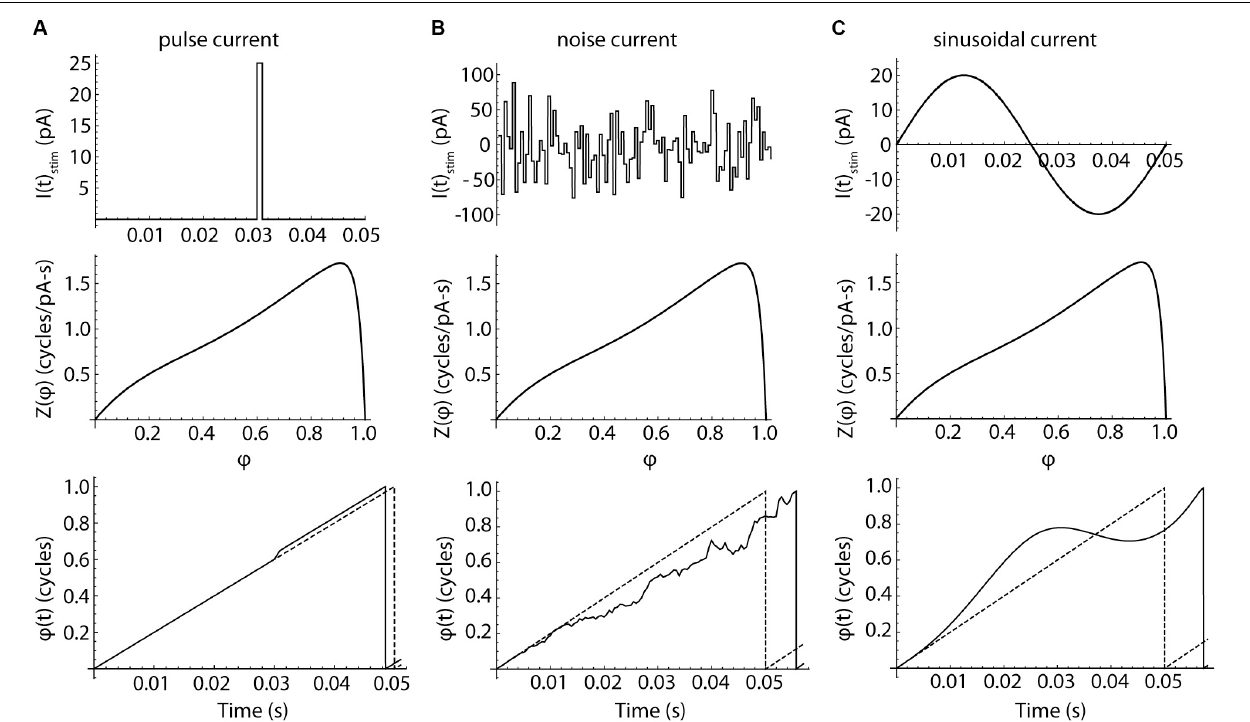
FIGURE 7 | The responses of phase neurons. (A) Response to a brief current pulse. Charge delivered by a current pulse (top) causes a phase shift in a noise-free neuron, whose phase otherwise advances at a constant rate F cell . The cell fires when its phase reaches a value of 1. The depolarizing pulse produces a change in spike time. The size of the phase shift and the change in the spike time are determined by the value of the phase resetting curve at the time of the stimulus. The evolution of phase over time in the absence of any perturbation is indicated by the dotted line. (B) Pulsed noise, like that used to measure spiking resonance, produces a sequence of phase shifts. Each pulse arrives at a phase determined by the entire sequence of preceding pulses. Pulses arriving at phases near the peak of the PRC are more influential than others, but the time of firing is determined by the entire waveform of input current. (C) Sinusoidal current produces a smoothly accumulating change in the time-evolution of phase. A sine wave stimulus can advance or delay the next action potential, depending on the phase of the stimulus relative to each